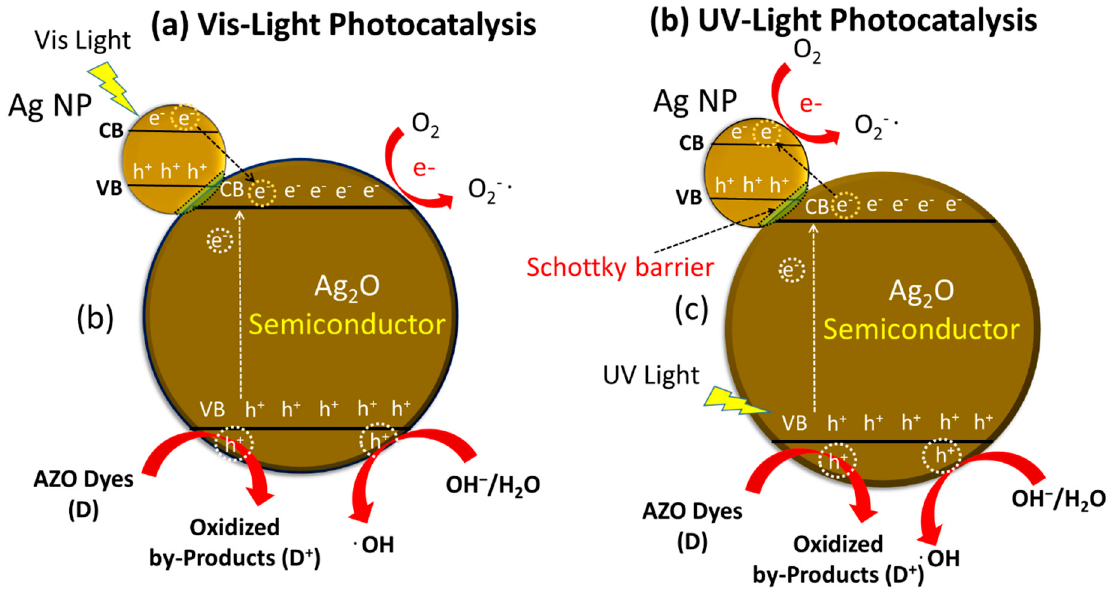
Figure 6. Schematic illustration of Ag/Ag 2 O towards photocatalytic degradation of organic pollutants (azo dye) under ( a ) visible light irradiation, ( b ) UV light irradiation.